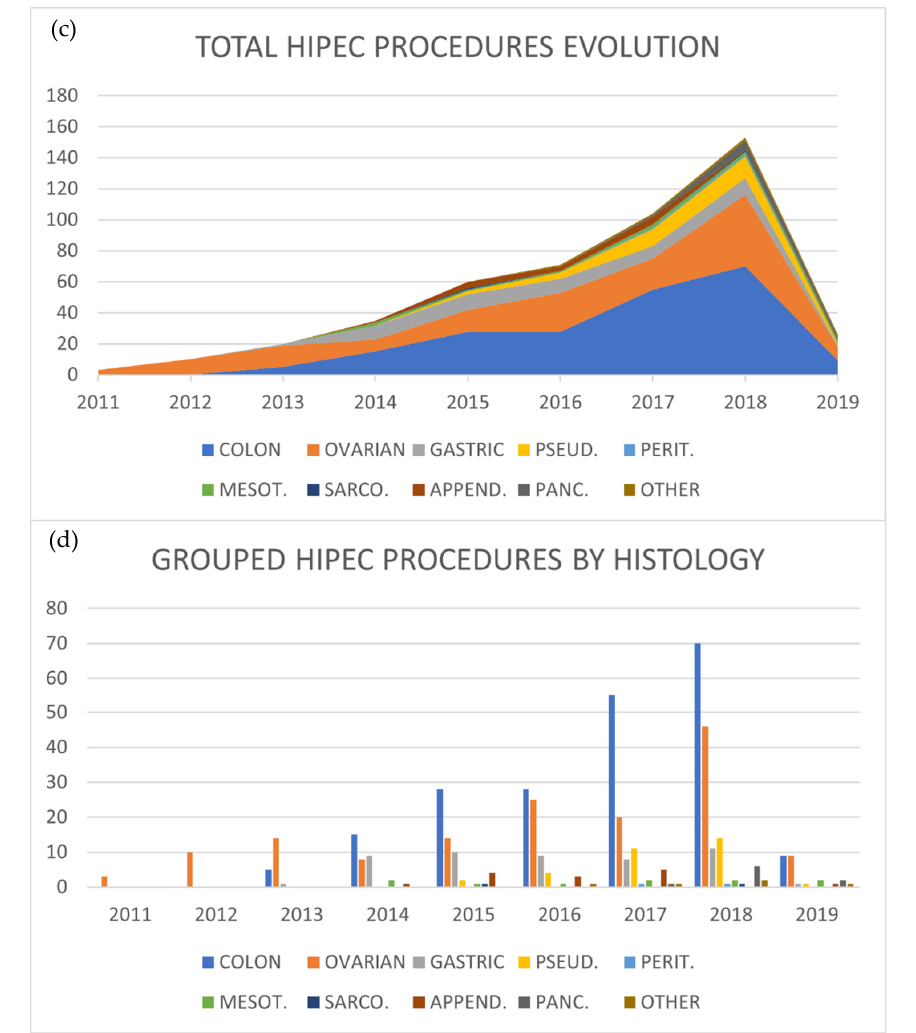
Figure 1. ( a ) Eleven participating hospitals. ( b ) Yearly increase of total HIPEC procedures. ( c ) Yearly increase of HIPEC procedures, with area proportional to histology, showing than the two main histologies are colon and ovarian origin. ( d ) Yearly evolution of HIPEC procedures with disaggregated yearly histology.